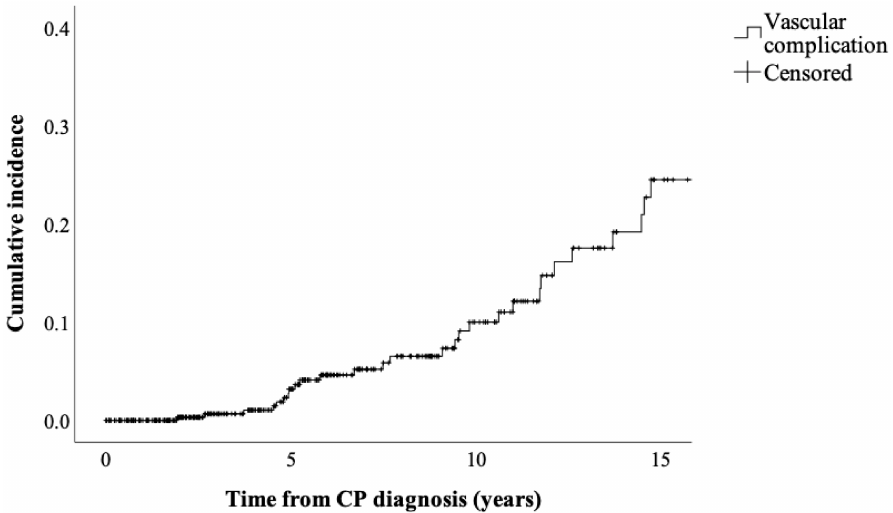
Figure 2. Cumulative incidence of vascular complications in patients with CP. Cumulative incidence was 3.2% at 5 years, 10% at 10 years and 24.5% at 15 years. CP—chronic pancreatitis.